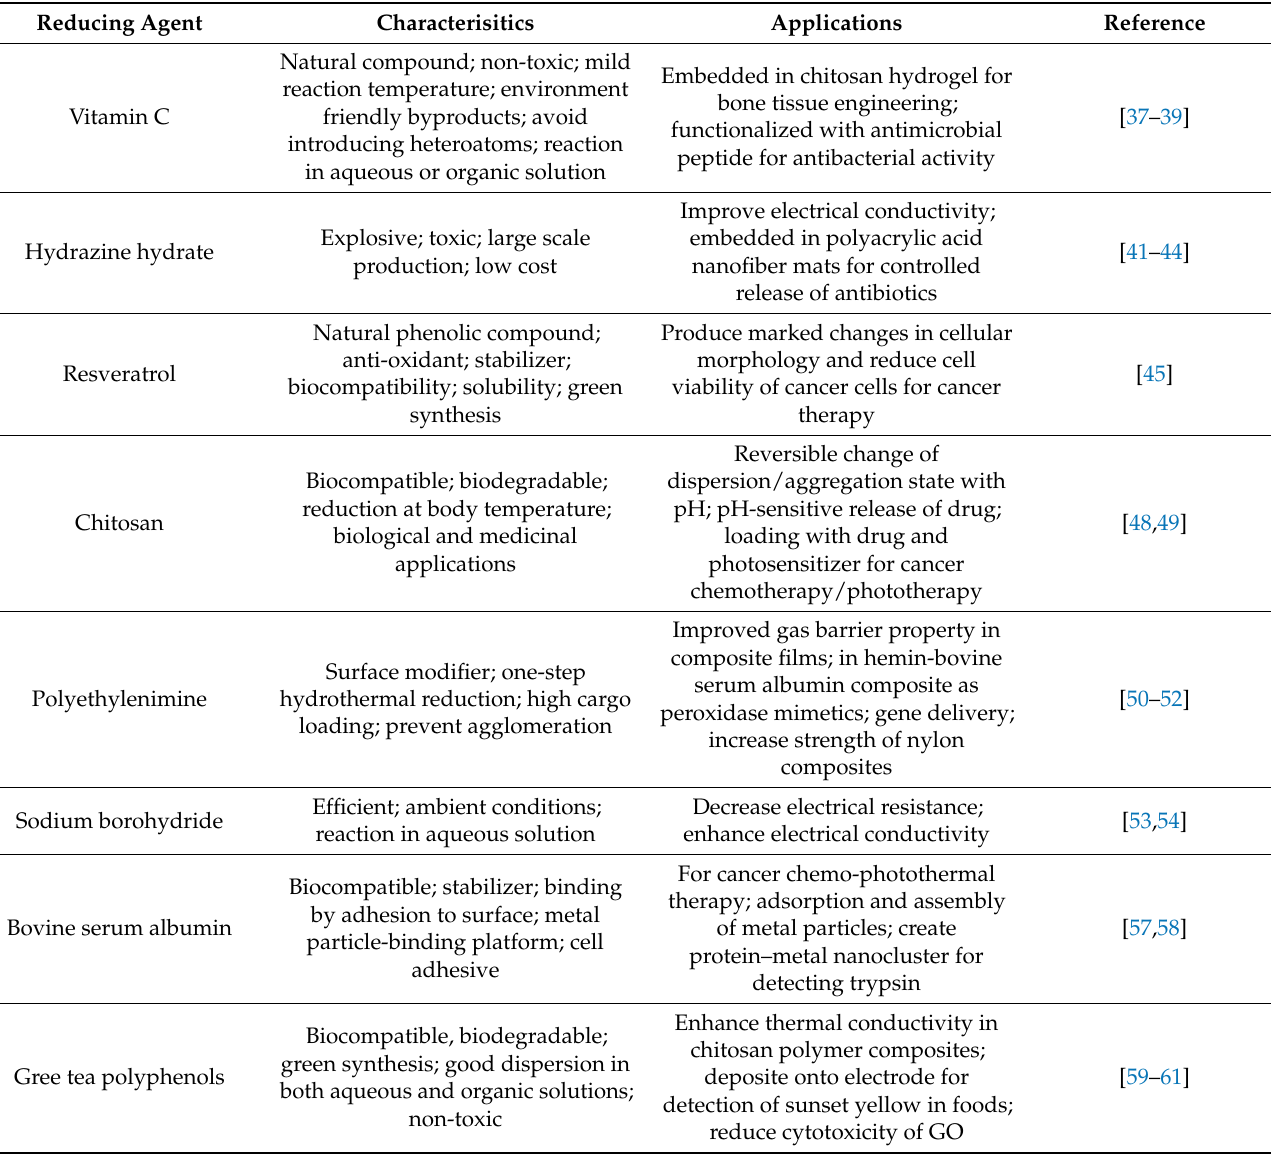
Table 1. Reducing agents for producing reduced graphene oxide (rGO) from graphene oxide (GO). Reducing Agent Characterisitics Applications